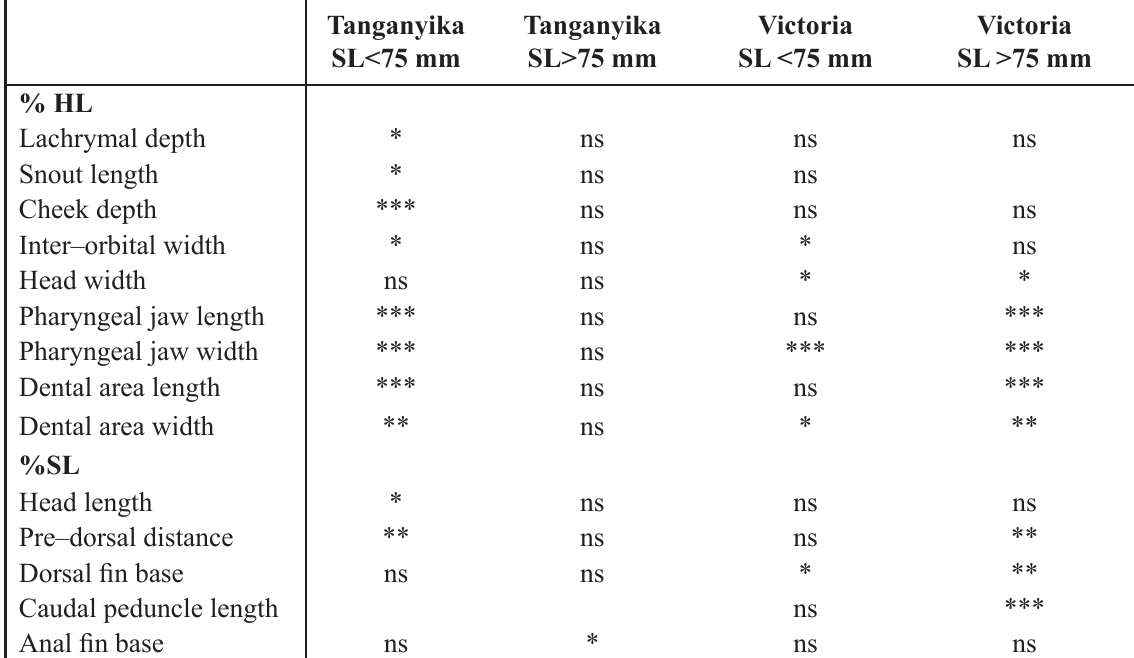
Table 4. Result from Mann-Whitney U-tests, comparing measurements of specimens of two size classes, SL < 75 mm and SL > 75 mm. Four comparisons were made (1-2) within the Tanganyika system between the Rusizi (n = 26, SL < 75 mm and n = 14, SL > 75 mm) and the Malagarazi (n = 31, SL < 75 mm and n = 9, SL > 75 mm) and (3-4) within the Victoria system between lakes Victoria-Kyoga and the Akagera system (n = 37, SL < 75 mm and n = 20, SL > 75 mm), and the remaining basins (lakes Edward, George, Kayanza, Nabugabo and Nakavali; n = 14, SL < 75 mm and n = 13, SL > 75 mm). Only variables with a significant difference are listed. Significant levels are based on Bonferroni